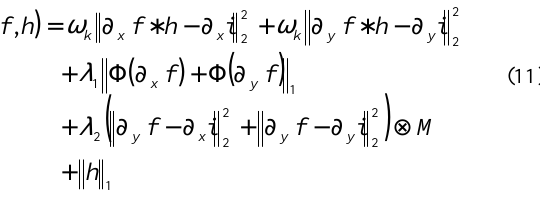
Figure 5. A binary mask obtained with a 21x21 pixels window